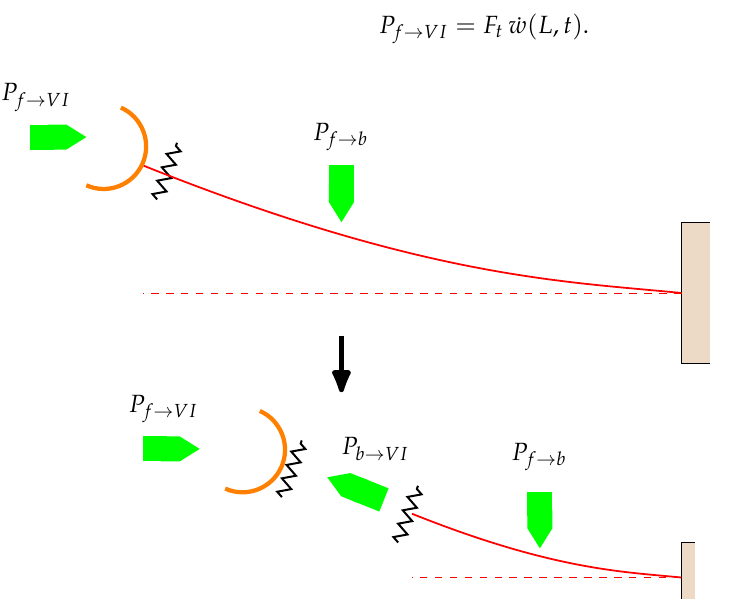
Figure 6. Power flows between the fluid and the FEH. To assess the accuracy of the modelling of the power transfer from the fluid to the beam, it is compared to the one transferred from the VI to the beam, the latter emerging as an internal power flow once the FEH is thought as composed by the VI and the